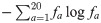
Entropy bias correction.(A) Each dot shows the entropy -∑a=120falogfa of a randomly sampled probability distribution over the 20 amino acids versus ∑a=120fa(1-fa) for the same distribution. (B) For each of the 150 Pfam MSA we plot the strength of the entropy bias correction α from Eq 21 versus N/L, where N is the number of sequences in the MSA and L is the number of columns. Without sequence weighting, a linear dependence would be expected from Eq 30.